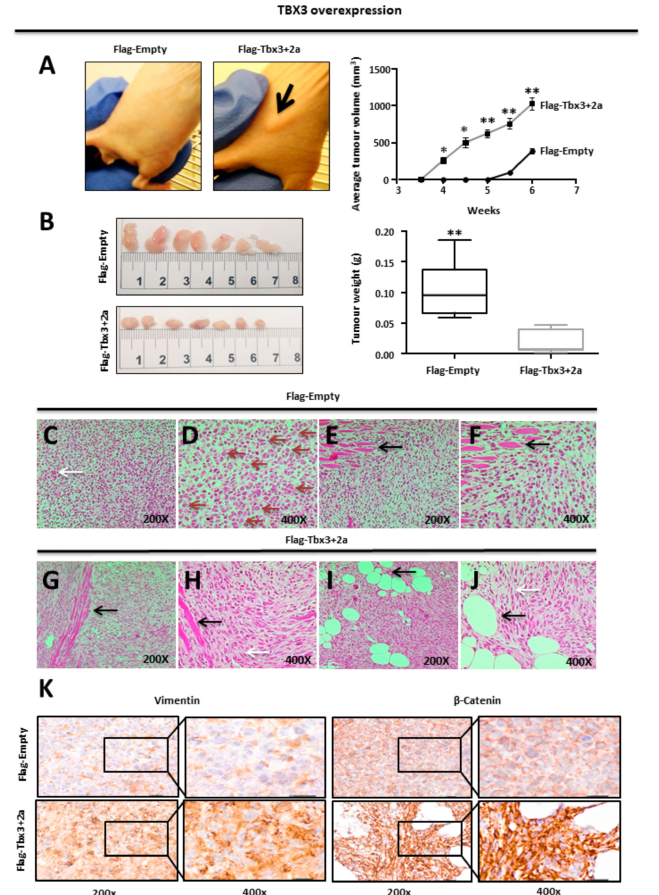
Figure 3. TBX3 overexpression promotes tumour-forming ability and invasiveness of ERMS xenografts. ( A ) RD Flag-Empty and Flag-Tbx3 + 2a cells were injected subcutaneously into the flanks of immunocompromised nude mice (N = 7 each). Mice were photographed at week 4 once visible tumour formation occurred (indicated by the black arrow) (top left panel). In situ tumour volume (mm 3 ) was measured over 6 weeks using calipers, average tumour volume pooled per group, error bars represent SD. ( B ) Mice were euthanized after 6 weeks and the tumours removed and photographed (right) and average tumour weight in grams was measured (left). Error bars represent SD. Student t -test was performed to calculate statistical significance (* p < 0.05, ** p < 0.001). ( C – J ) RD Flag-Empty and Flag-Tbx3 + 2a mouse xenograft tumour sections were processed and stained with haematoxylin and eosin (H&E) for histopathological analyses. ( C – F ) RD Flag-Empty tumour tissue sections with classic di ff use round polygonal cells, tumour giant cells (C, white arrow), mitotic cells ( D , red arrows) and invasion into skeletal muscle ( E , F , black arrows). ( G – J ) RD Flag-Tbx3 + 2a tumour tissue sections with predominant fascicular growth of round and spindle-shaped cells ( H , J , white arrows) and invasion into skeletal muscle ( G , H , black arrows) and adipose tissue ( I , J , black arrows). ( K ) Immunohistochemical analysis of RD Flag-Empty and Flag-Tbx3 + 2a mouse xenograft tumour tissues sections stained with antibodies specific to the EMT markers, Vimentin and β -Catenin. Representative phase contrast light microscopic images were taken at 200 × and 400 ×